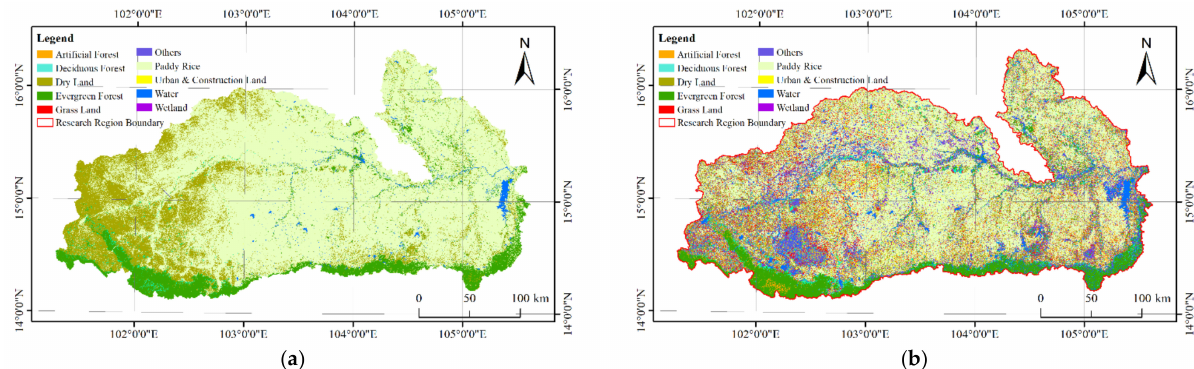
Figure 13. Classification result of the ESTARFM in the Mun River Basin. ( a ) is the classification result of an objected-oriented method with the SVM classifier (i.e., LC4), and ( b ) is the classification result of the ED-similarity measure method (i.e., LC5).